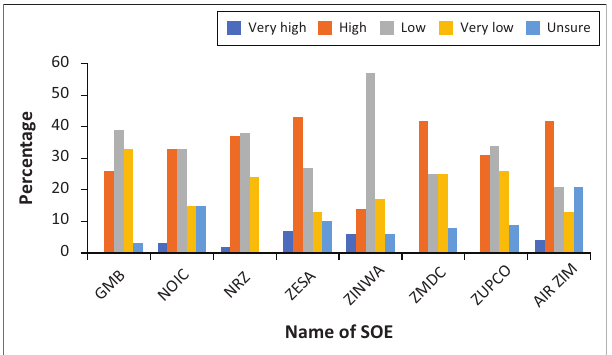
FIGURE 3: Responses on the view that state-owned enterprises met most of their equipment requirements.